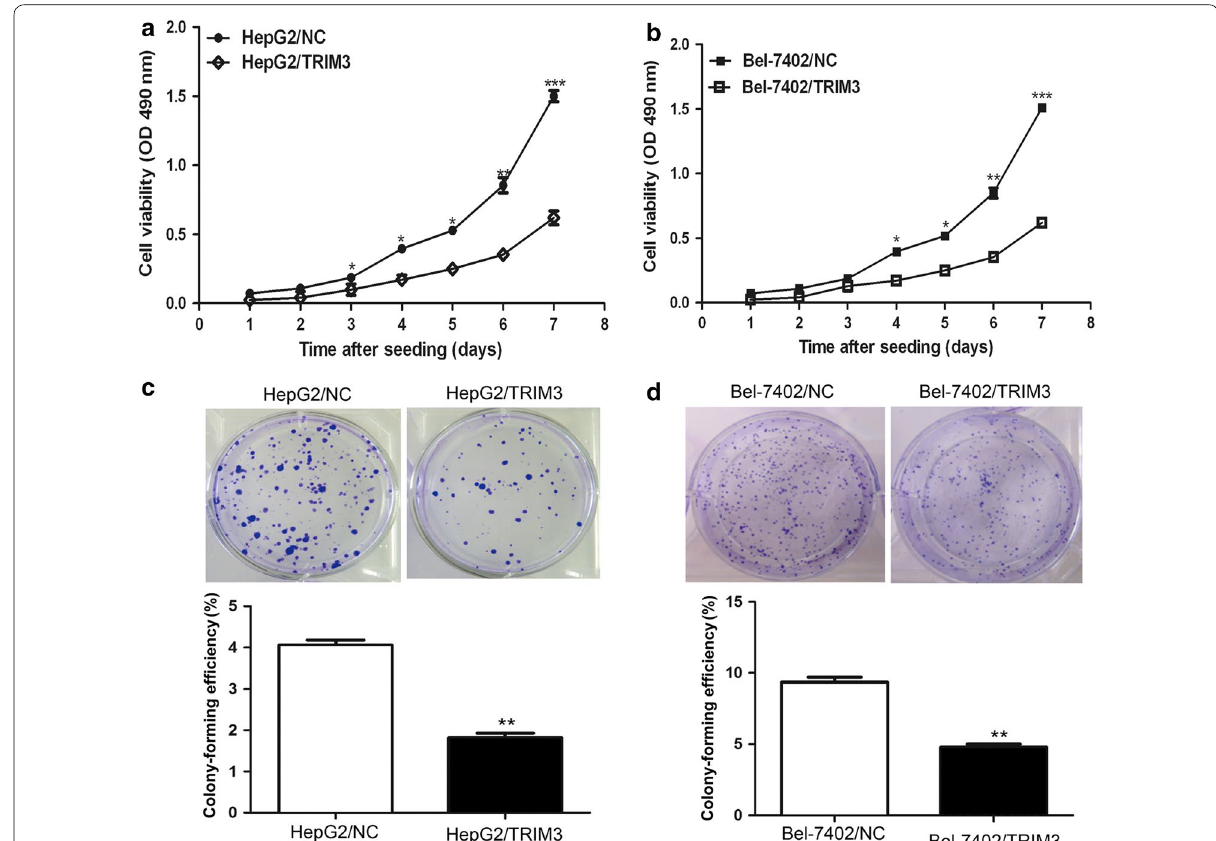
Fig. 2 Inhibitory effect of TRIM3 on the growth of HepG2 and Bel‑7402 cells. a , b Cell proliferation assay results show that TRIM3 overexpression suppressed the proliferation of HepG2 ( a ) and Bel‑7402 ( b ) cells. OD, optical density. c , d Top representative images of decreased colony formation of HepG2/TRIM3 and Bel‑7402/TRIM3 cells in a monolayer culture. Bottom colony‑forming efficiencies were calculated after 12‑day conventional culture. Measurements were carried out in triplicate, and experiments were repeated three times. Data are presented as mean calculated using Student’s t test. * P < 0.05, ** P < 0.01, and *** P < 0.001, versus cells transfected with